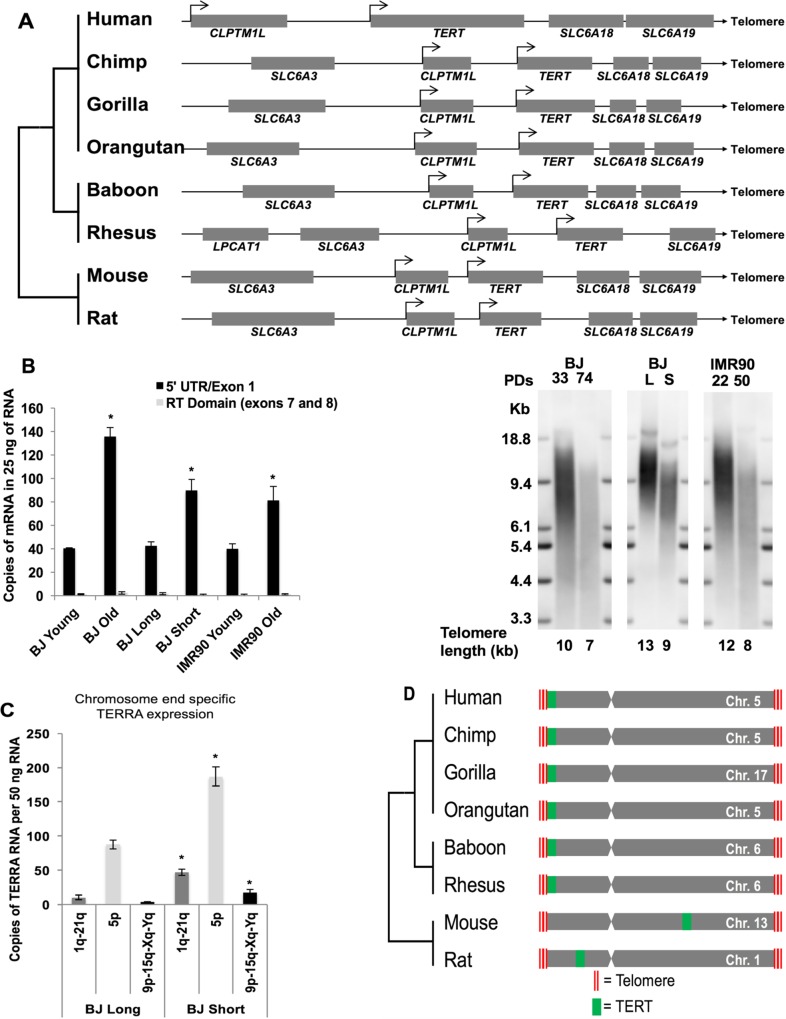
Conserved TERT loci in higher primates.(A) Conserved synteny map of TERT and CLPTM1L loci in mammals. Transcription orientation of TERT and location of telomere are shown in figure. (B) ddPCR analyses of the hTERT locus. mRNA expression in BJ cell lines at young population doublings (PD34) and old (PD74), BJ cell clones containing different telomere lengths, and IMR90 young (PD22) and old (PD50) were analyzed. RNA (1000ng) was reverse-transcribed, diluted, and 5ʹ hydrolysis probes (Roche UPL) were used to assess the number of mRNA molecules per reaction. Mean telomere length was analyzed by TRF in each of the analyzed cell lines. (C) Chromosome end-specific TERRA expression analysis was performed on BJ cell clones with long and short telomeres (same RNA as used above for TERT analysis). (D) Higher primates also retain the location of the TERT gene at the end of their chromosomes. Each bar represents an individual chromosome retaining the TERT locus. Location of the TERT gene is marked by green on the chromosome. Red bar represents location of telomeres. * = p < 0.05. kb = kilobases. Data are presented as means and standard errors of biological replicates and technical triplicates. Data associated with this figure can be found in the supplemental data file (S1 Data).